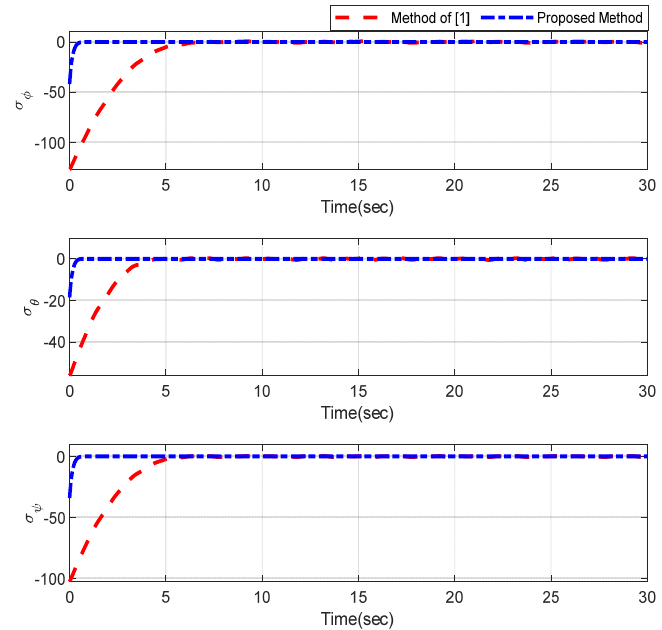
Figure 6. Sliding surfaces related to the position.